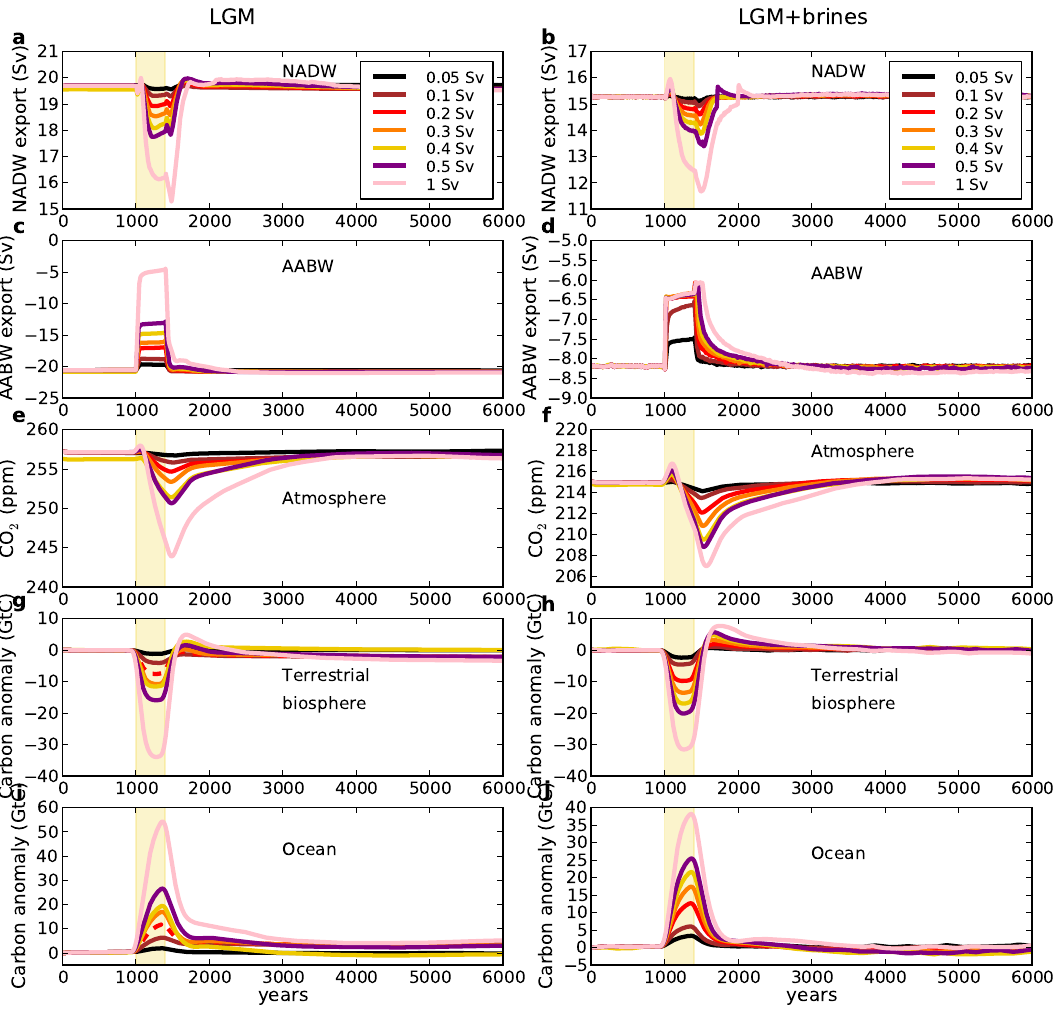
Fig. 17. Evolution of oceanic variables in response to the addition of fresh water into the southern part of the Atlantic following the “Amplitude” experiments (Fig. 1c). (a, b) NADW export (Sv) (maximum of the AMOC), (c, d) AABW export (Sv) (maximum of the overturning cell in the Southern Ocean, the sign indicates that the transport is from the South to the North), (e, f) atmospheric CO 2 (ppm), (g, h) carbon content anomaly in the terrestrial biosphere (GtC) and (i, j) carbon content anomaly in the ocean (GtC). The simulations are performed with two background climate states: (a, c, e, g, i) during the Last Glacial Maximum (LGM) and (b, d, f, h, j) during the Last Glacial Maximum with the sinking of brines